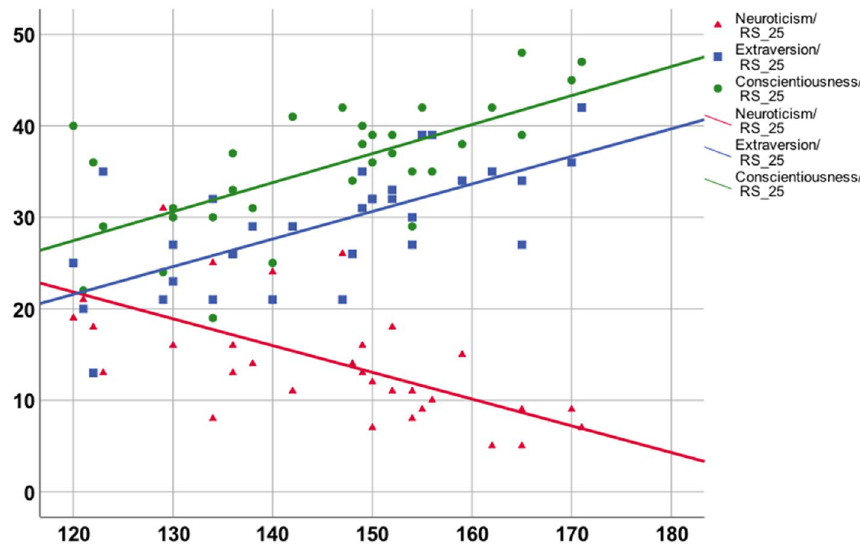
Figure 2. Correlations between RS-25 and three subscales of the NEO-personality scale: extraversion, conscientiousness and